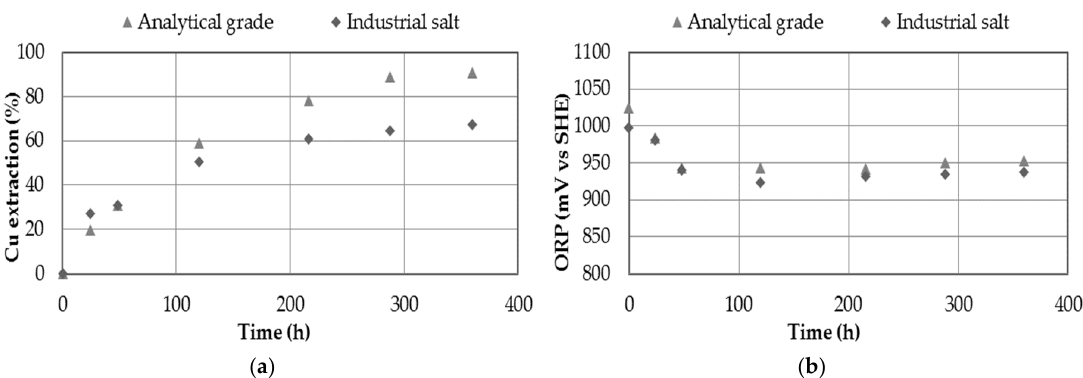
Figure 10. a) Copper extraction (%) versus time (h) when different nitrate sources were used: analytical grade and industrial salt. b) Redox potential (mV) versus time (h) when different nitrate sources were used: analytical grade and industrial salt. Experimental conditions: [NaNO 3 ] = [H 2 SO 4 ] = 0.7 M, 45 ◦ C, seawater as dissolvent and sample A.